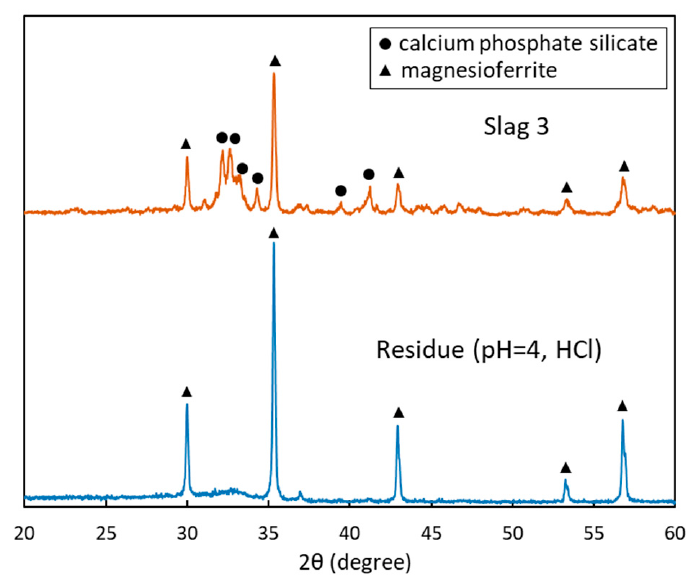
Table 4. Composition of mineral phases on the residue surface (mass%).